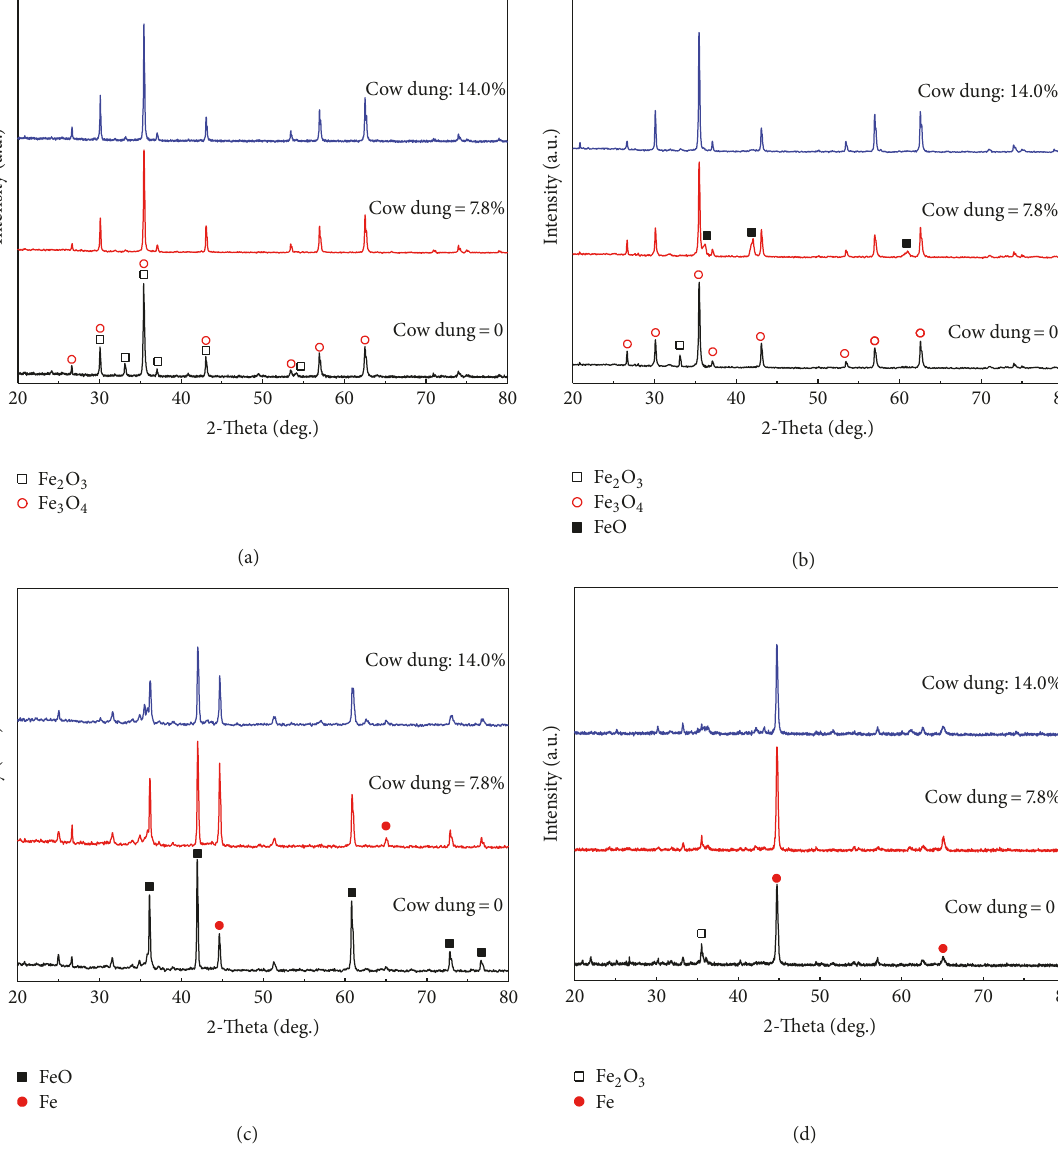
Figure 7: XRD of different carbon-bearing pellets after reduction at different temperatures. (a) 873 k; (b) 1073 k; (c) 1273 k; (d) 1523